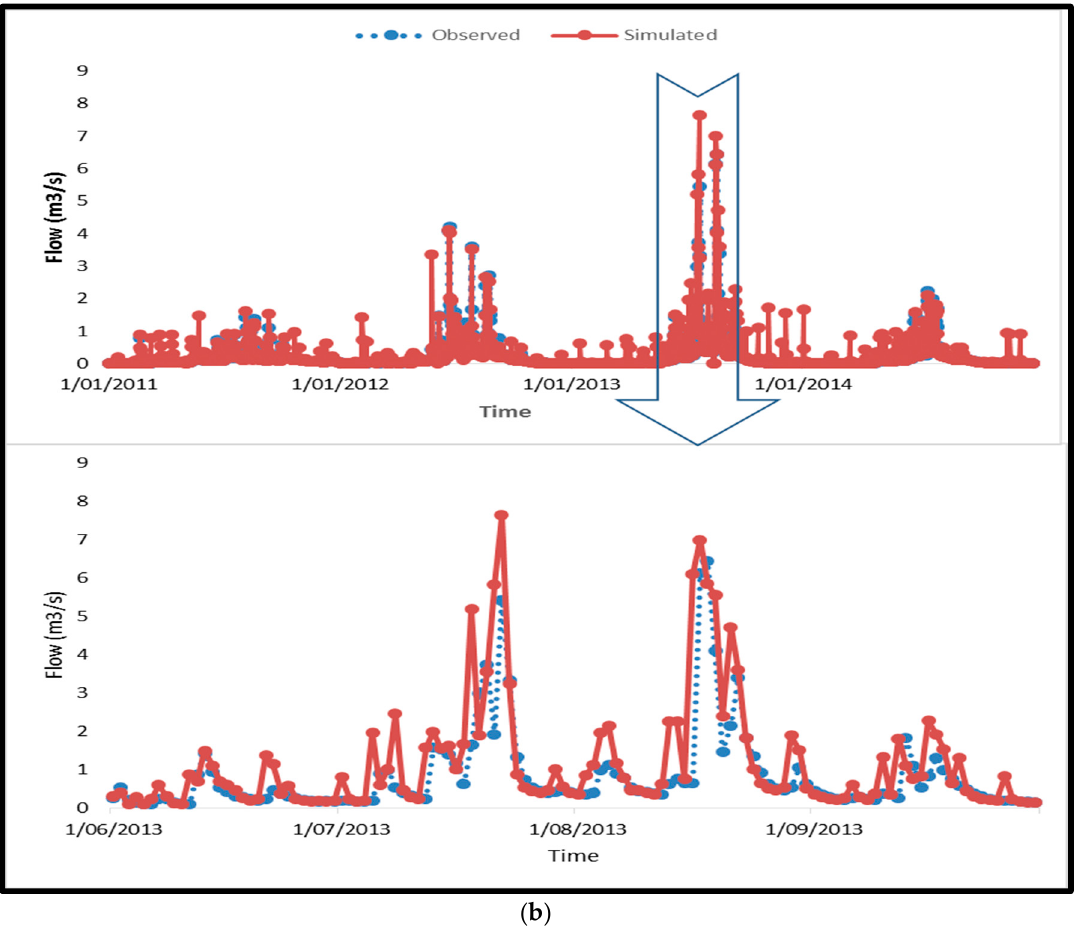
Figure 5. ( a ) Comparison of the simulated and observed flow series during calibration; ( b ) Comparison of the simulated and observed flow series during validation.